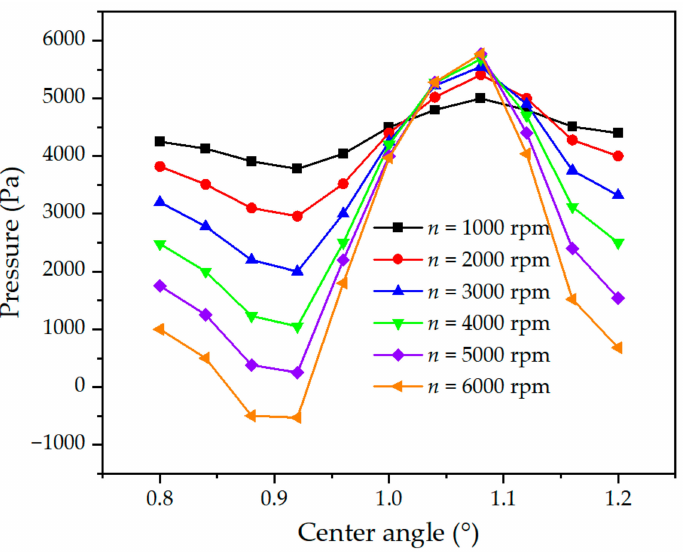
Figure 28. Pressure distribution in texture dimple without cavitation effect at different rotational